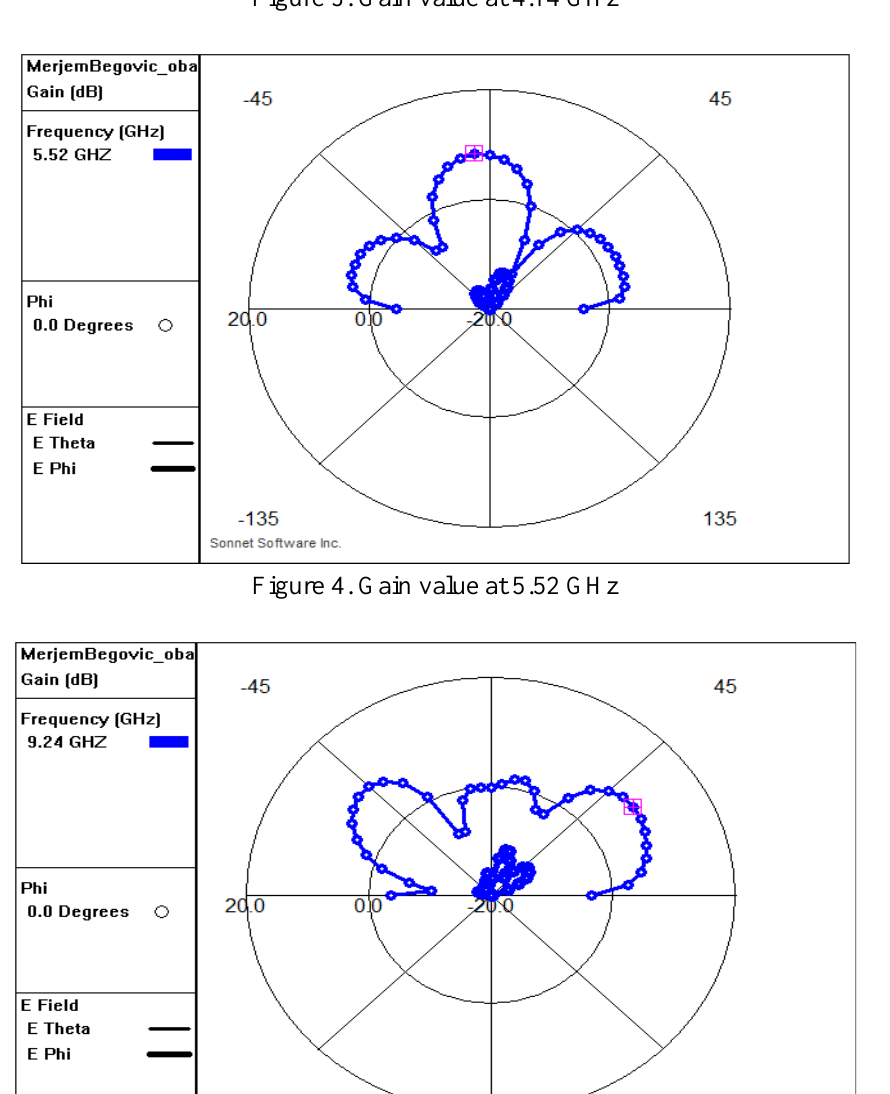
Figure 3. Gain value at 4.14 GHz